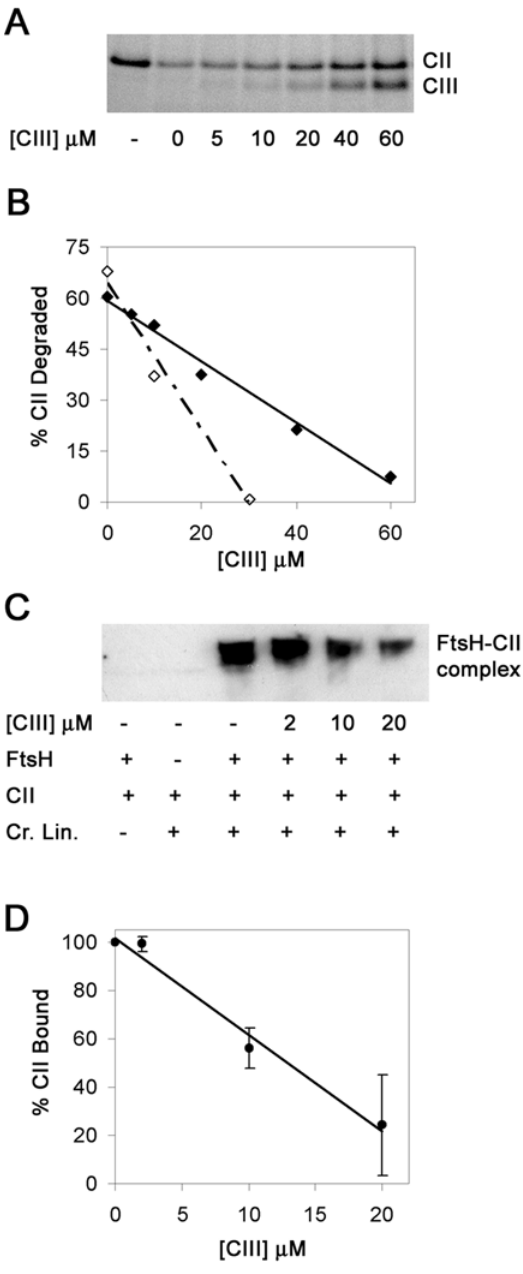
Figure 4. Purified CIII acts as a competitive inhibitor of FtsH. ( A ) 4 m M of CII were incubated with 1 m M GST-FtsH at 42 0 C for 5 minutes in the presence of increasing concentrations (as specified) of His 6 -CIII. The reactions were loaded on 4–12% NuPAGE (invitrogen) and visualized by Coomassie stain. First lane indicates the amount of CII at starting time. ( B ) The CII levels remaining after degradation experiment shown in A, were calculated using the ‘‘NIH image’’ program and plotted versus CIII levels (full diamonds and full lines). A similar experiment with only 1 m M of CII being degraded is shown in empty diamonds and a dotted line. ( C ) The binding assays were done in the presence of 10mM AMP-PNP as described in the materials and methods. The reactions were loaded on 4–12% NuPAGE (invitrogen) and visualized by western blotting using antibodies raised against the CII protein. ( D ) CII levels bound in complex to GST-FtsH were calculated using the ‘‘NIH image’’ program and average from two different experiments was plotted versus CIII levels. The error bars are + / 2